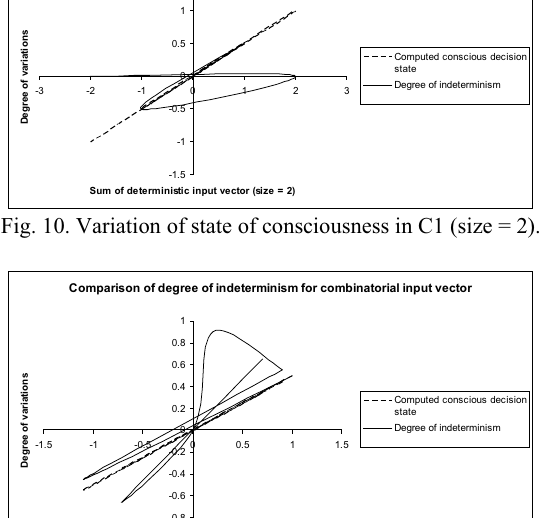
Fig. 9. Delay-density distribution between nodes.